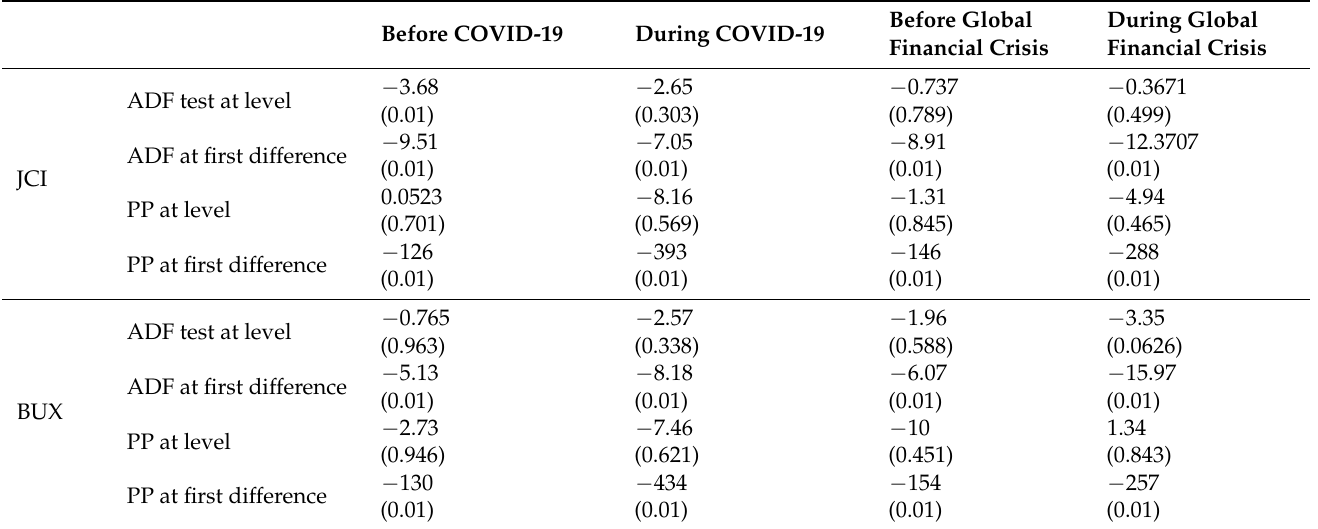
Table 6. Unit Roots Test.